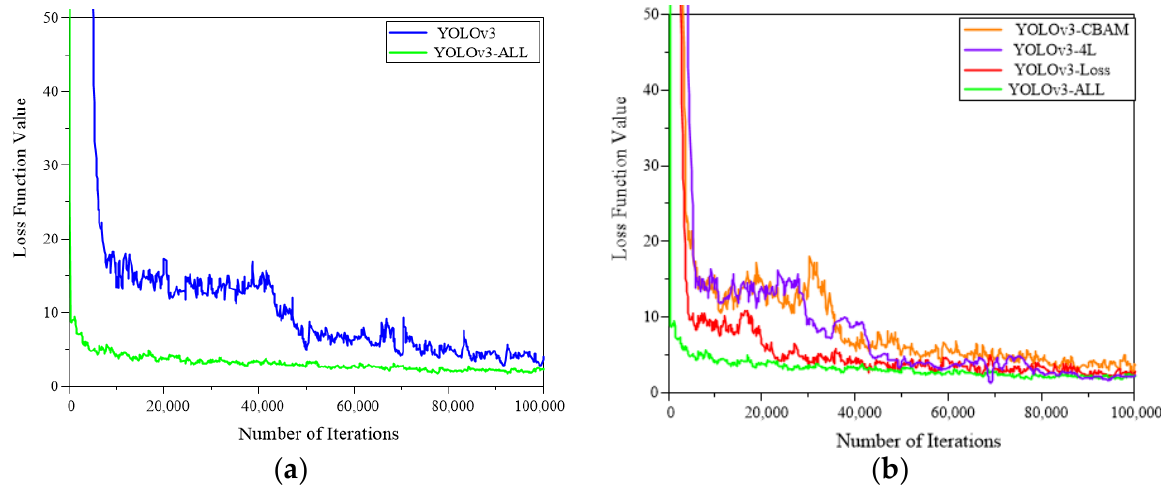
Figure 14. Comparison of four loss function curves. ( a ) The loss function values of YOLOv3 and YOLOv3-ALL; ( b ) The loss function values of YOLOv3-ALL, YOLOv3-CBMA, YOLOv3-4L, and YOLOv3-Loss. Table 6. Experimental performance evaluation.